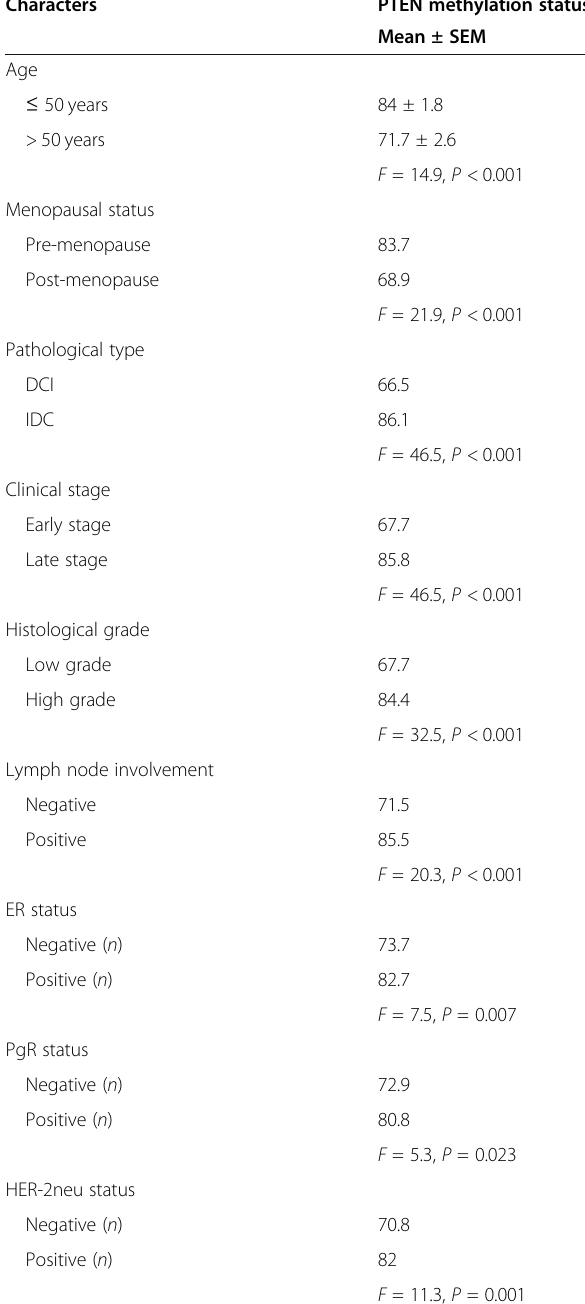
Table 3 Mean level of PTEN methylation status among clinicopathological factors